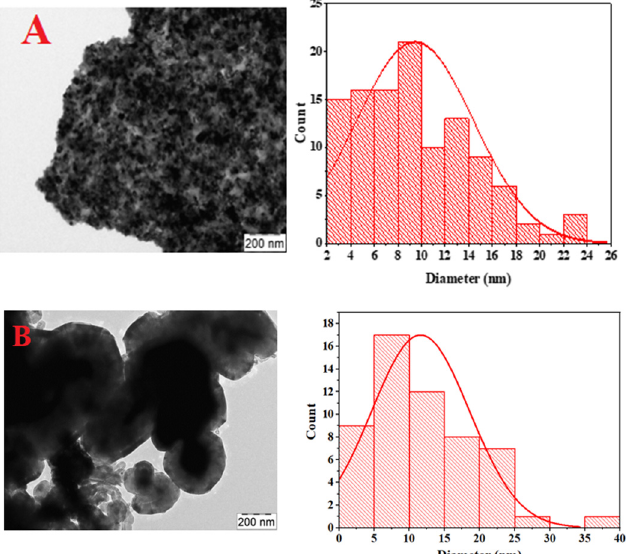
Figure 5. TEM micrographs and matching particle size distribution for fresh CeNi 0.9 Zr 0.1 O 3. ( A ) and used CeNi 0.9 Zr 0.1 O 3. ( B ) catalyst.